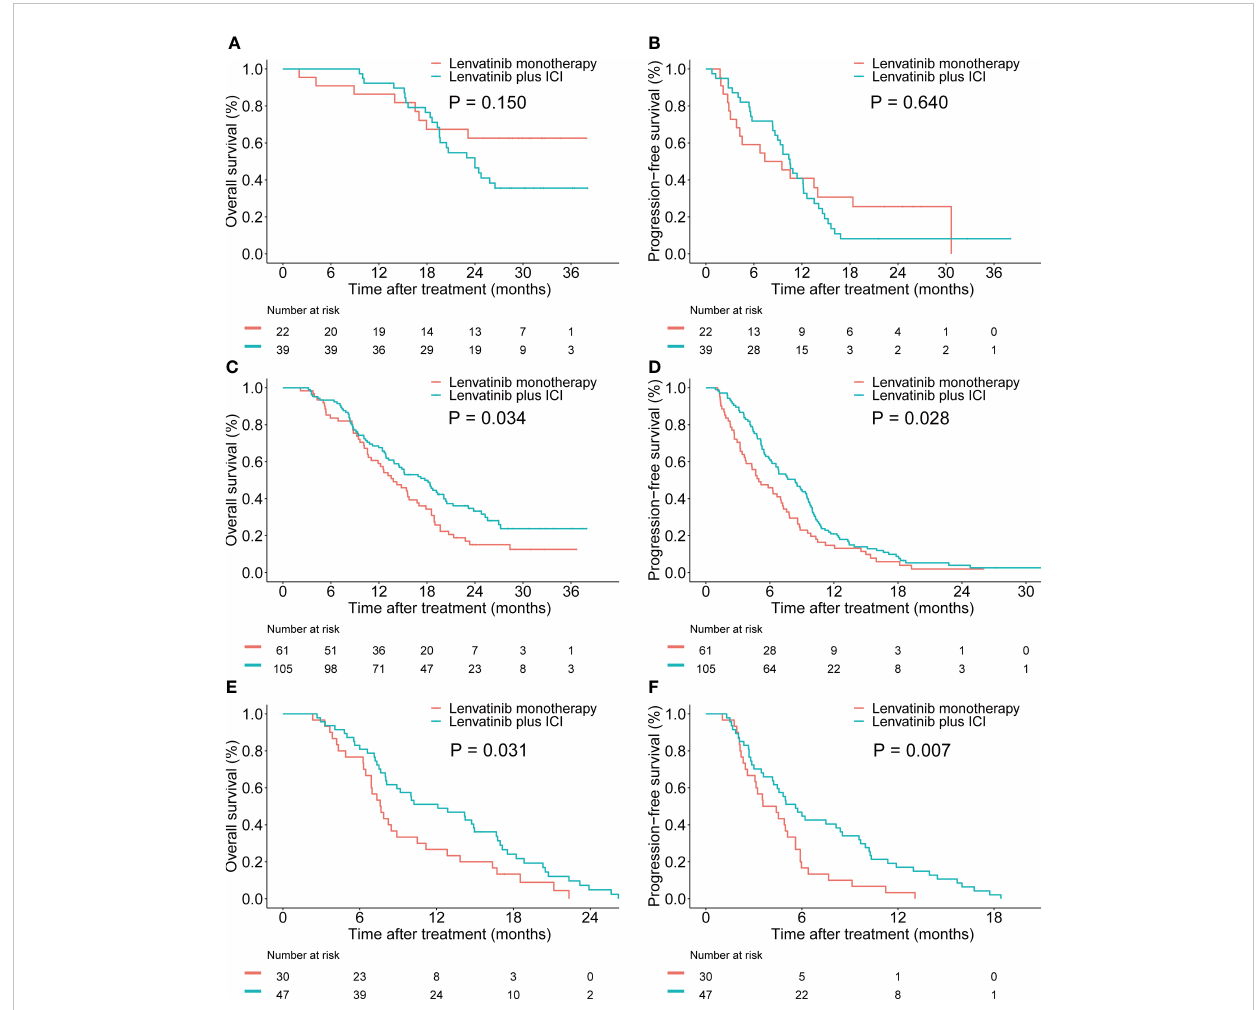
FIGURE 4 Ef fi cacy of lenvatinib monotherapy and lenvatinib plus ICI in patients with unresectable HCC strati fi ed by PIMET score. (A) The Kaplan-Meier survival curves of OS according to the treatment regimens in the PIMET-low group. (B) The Kaplan-Meier survival curves of PFS according to the treatment regimens in the PIMET-low group. (C) The Kaplan-Meier survival curves of OS according to the treatment regimens in the PIMET-int group. (D) The Kaplan-Meier survival curves of PFS according to the treatment regimens in the PIMET-int group. (E) The Kaplan-Meier survival curves of OS according to the treatment regimens in the PIMET-high group. (F) The Kaplan-Meier survival curves of PFS according to the treatment regimens in the PIMET-high group. HCC, hepatocellular carcinoma; ICI, immune checkpoint inhibitor; OS, overall survival; PFS, progression-free